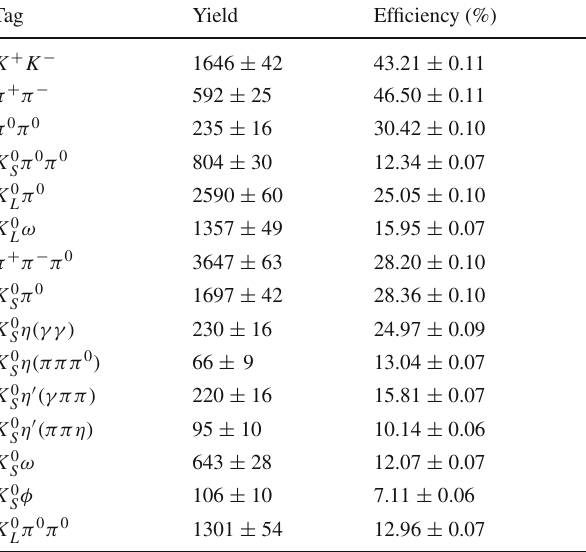
Table 4 Summary of double-tag yields. Also shown are the selection efficiencies as determined from MC simulation, which are defined rel- ative to the exclusive final state in which each channel is reconstructed. The uncertainties are statistical